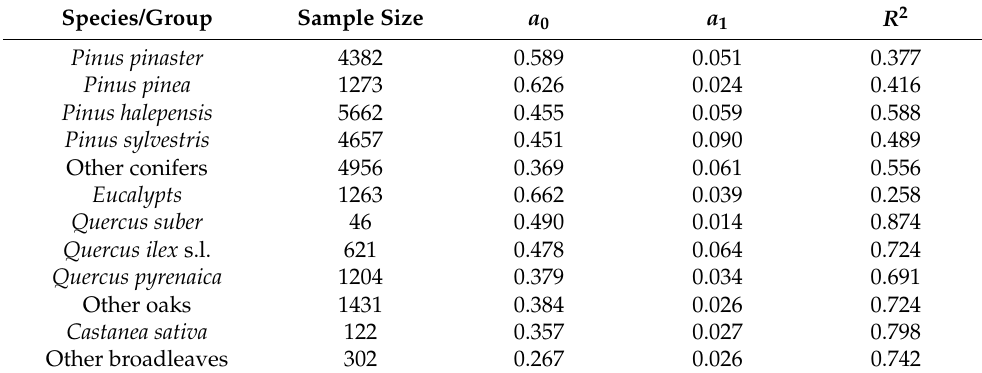
Table 2. Parameter estimates and coefficients of determination for the tree species or group of species obtained fitting Equation (12) to model Crown Length (CL) as a function of a reference distance